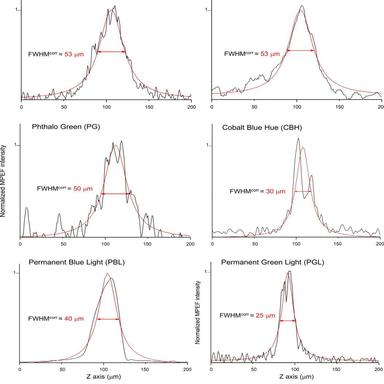
Z-Scans of the MPEF signals of Cu-Pc paint samples (in black) and fits by a Lorentzian function (in red). The corresponding FWHM values after refractive index corrections are indicated in red.